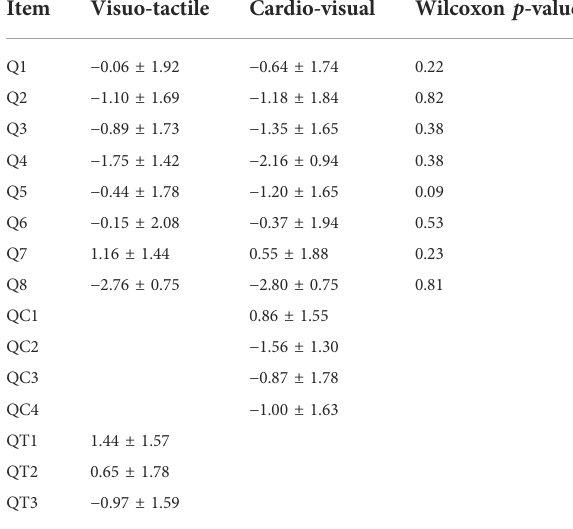
TABLE 2 Quotes of self-reported feelings from the illusion questionnaire scaled in a − 3 to +3 Likert scale. Wilcoxon p -values indicate no distinction between each